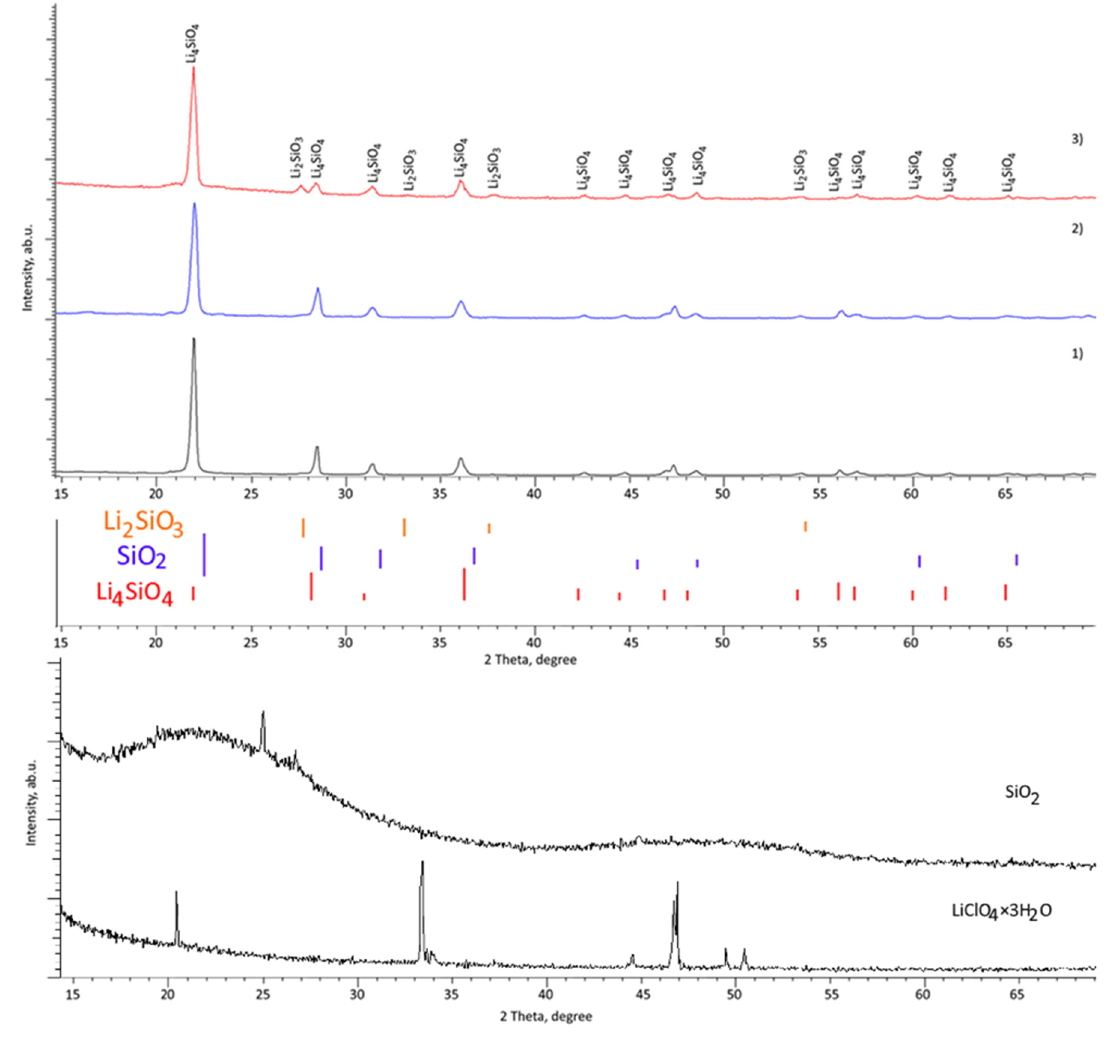
Figure 1. Results of X-ray diffraction of the studied samples obtained at different concentrations of the LiClO 4 :SiO 2 components: (1) 0.1:0.9 (2) 0.25:0.75; (3) 0.5:0.5 (the figure shows the bar graphs of the positions of the diffraction reflections of the reference values for various phases, as a comparison, the positions of the main lines for the Cristobalite (SiO 2 ) phase are shown). X-ray diffraction patterns of the initial components LiClO 4 ×3H 2 O and SiO 2 are presented.